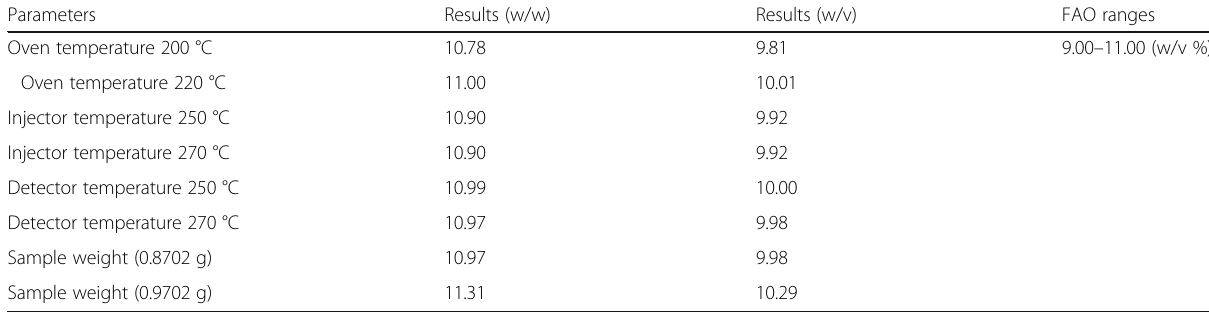
Table 4 Summarized data for